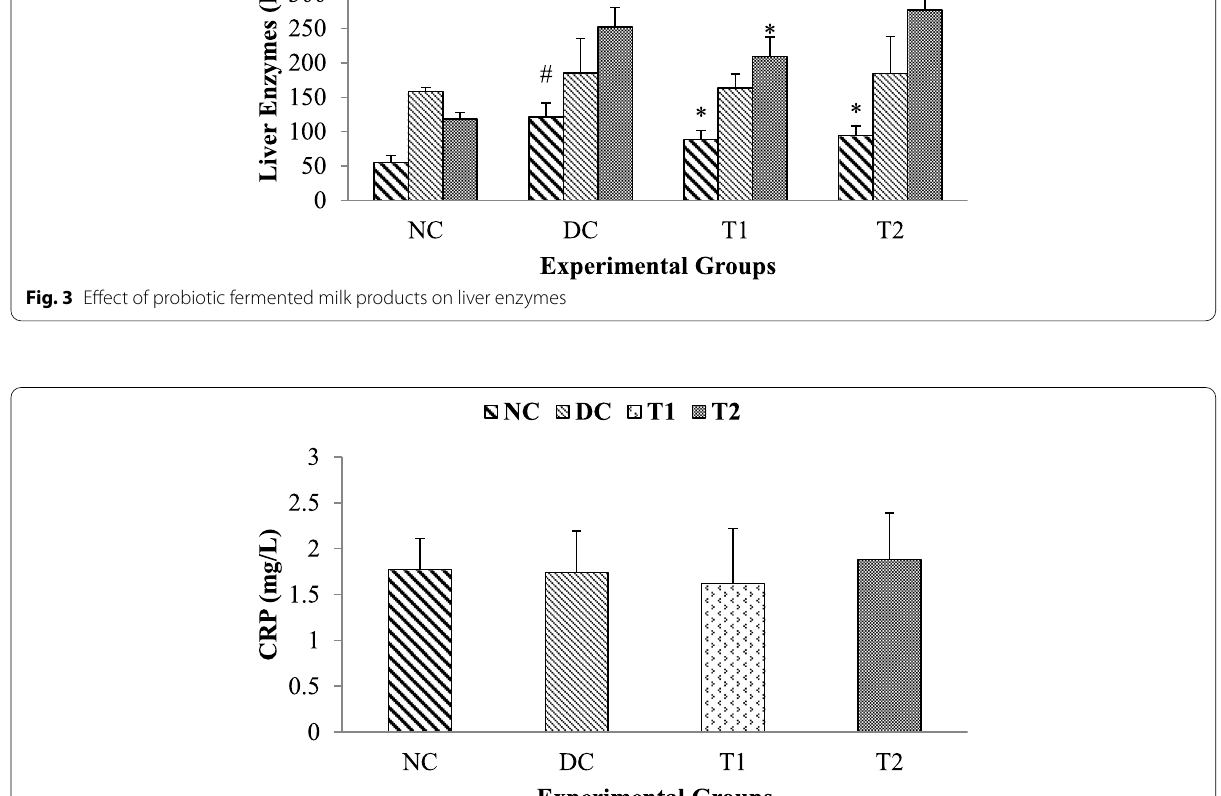
Fig. 4 Effect of probiotic fermented milk products on CRP. (NC SPI, T2 probiotic fermented milk without WPC and SPI) Statistical analysis was performed by applying one-way ANOVA followed by Dunnet’s Test = using Graph Pad Prism V6.0. Statistical significance was kept at P < 0.05 and P < 0.01. #-Indicate significant difference from Normal control group. *-Indicate significant difference from Disease control